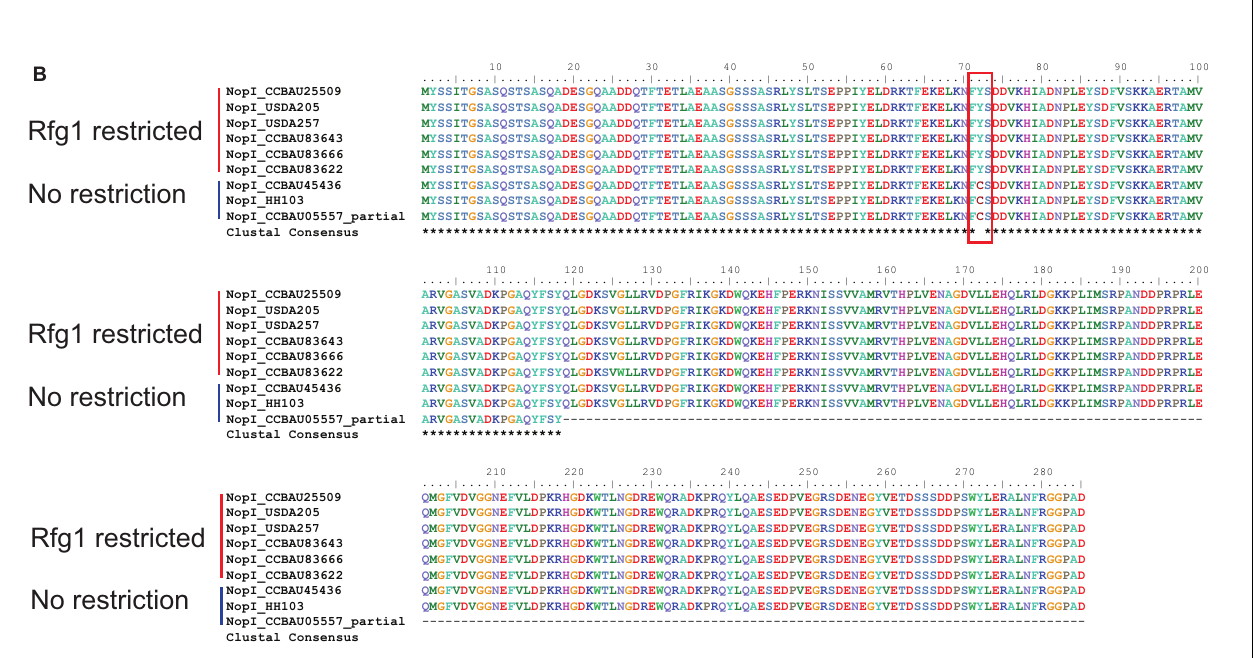
relationships with soil rhizobia (Dixon and Kahn, 2004).